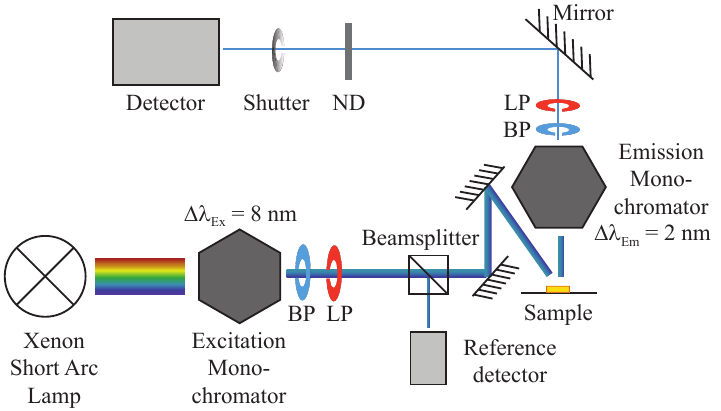
Figure 3. Sketch of a fluorescence spectrometer for diffuse reflectance measurements. BP: band-pass filter, LP: long-pass filter, ND: neutral density